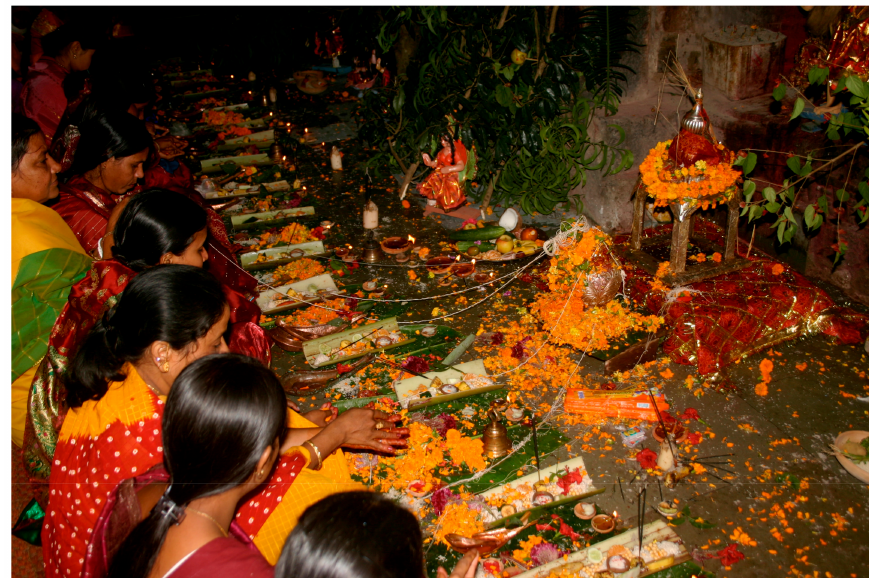
Figure 2. Women linked to the b¯axum by a silk thread (the water jar is considered to be Kr.s.n.a or a perfect husband).